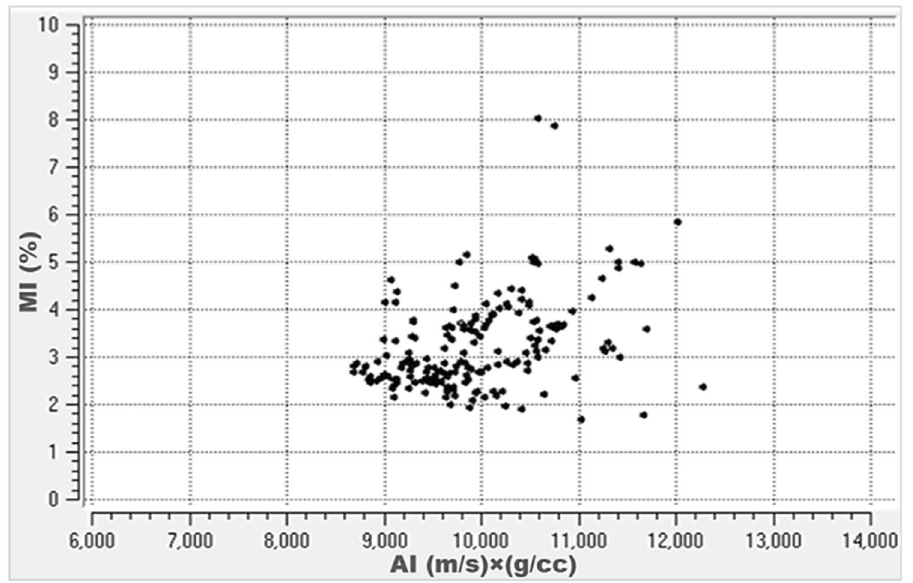
Figure 11. Maturity index (MI) versus acoustic impedance (AI) cross-plot.